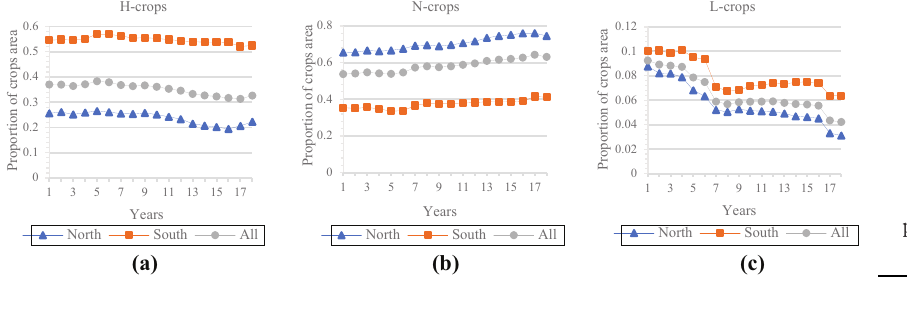
Figure 2. Change of corps planted in different